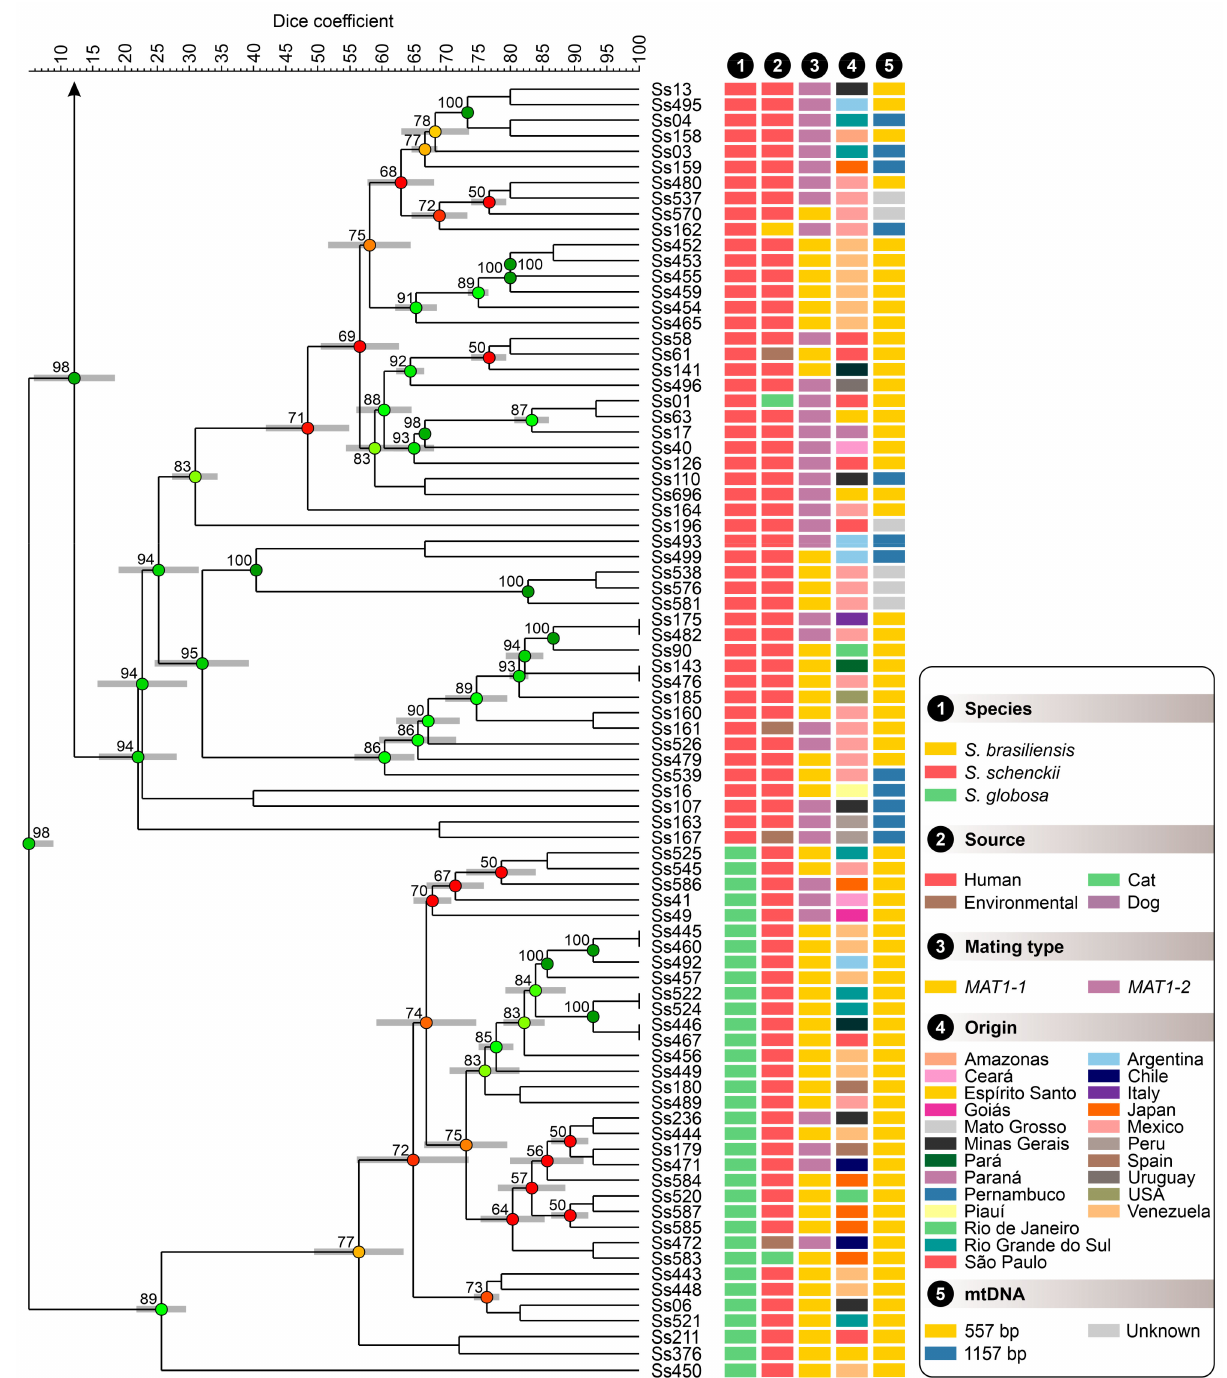
Figure 6. The UPGMA dendrogram, based on SSR markers, generated with a total of 15 SSR markers for 180 Sporothrix isolates originated worldwide. The dendrogram shows cophenetic correlation values (circles are represented by color ranges between green-yellow-orange-red according to de- creasing cophenetic correlation) for a given clade and its standard deviation (grey bar). For pairwise genetic distances calculation, the Dice similarity coefficient was used. The cophenetic correlation of the dendrogram is 98%. Further information about isolate sources can be found in Supplementary Table